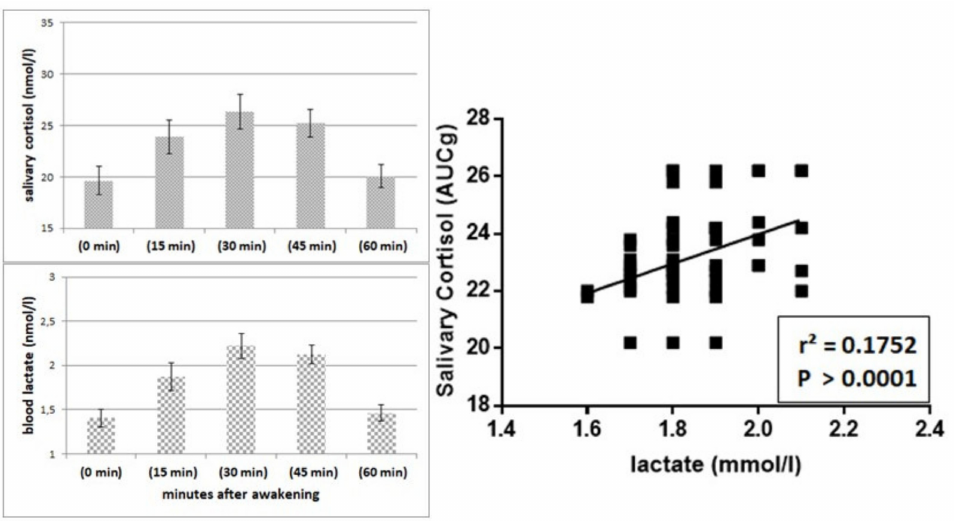
Figure 5. Relationship between salivary cortisol and blood lactate. On the left, the reader can observe the remarkable similarity of changes in salivary cortisol and blood lactate over the course of 60 min after awakening. On the right, however, one can appreciate the significantly positive linear relationship between the mean values of salivary cortisol and blood lactate in the 90 participants of the